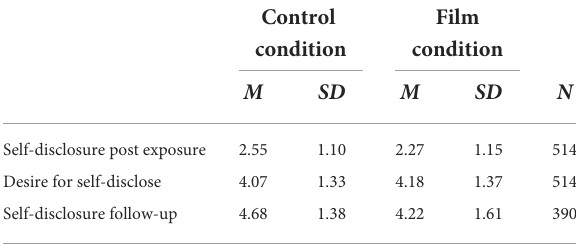
TABLE 3 Mean and standard deviation of self-disclosure responses in the control and film conditions in Study